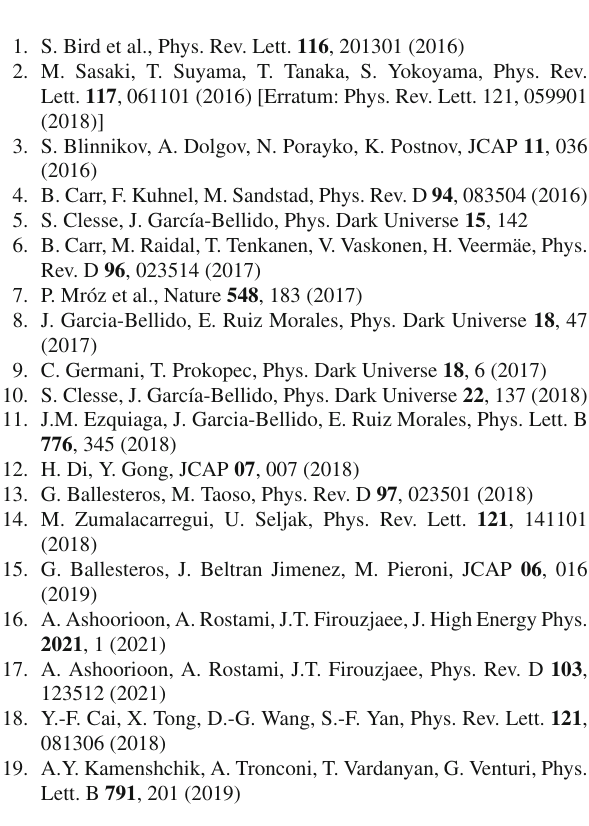
of induced GWs behaves almost as the power-law function ∼ f n in various intervals of frequency. For each case (cid:3) GW0 of our model, we presented the values of the constant param- eter n for different frequency domains and showed that the results for the infrared regime f (cid:9) f c are in good agree- ment with the analytical expression (cid:3) GW0 ∼ f 3 − 2 / ln ( f c / f ) obtained by